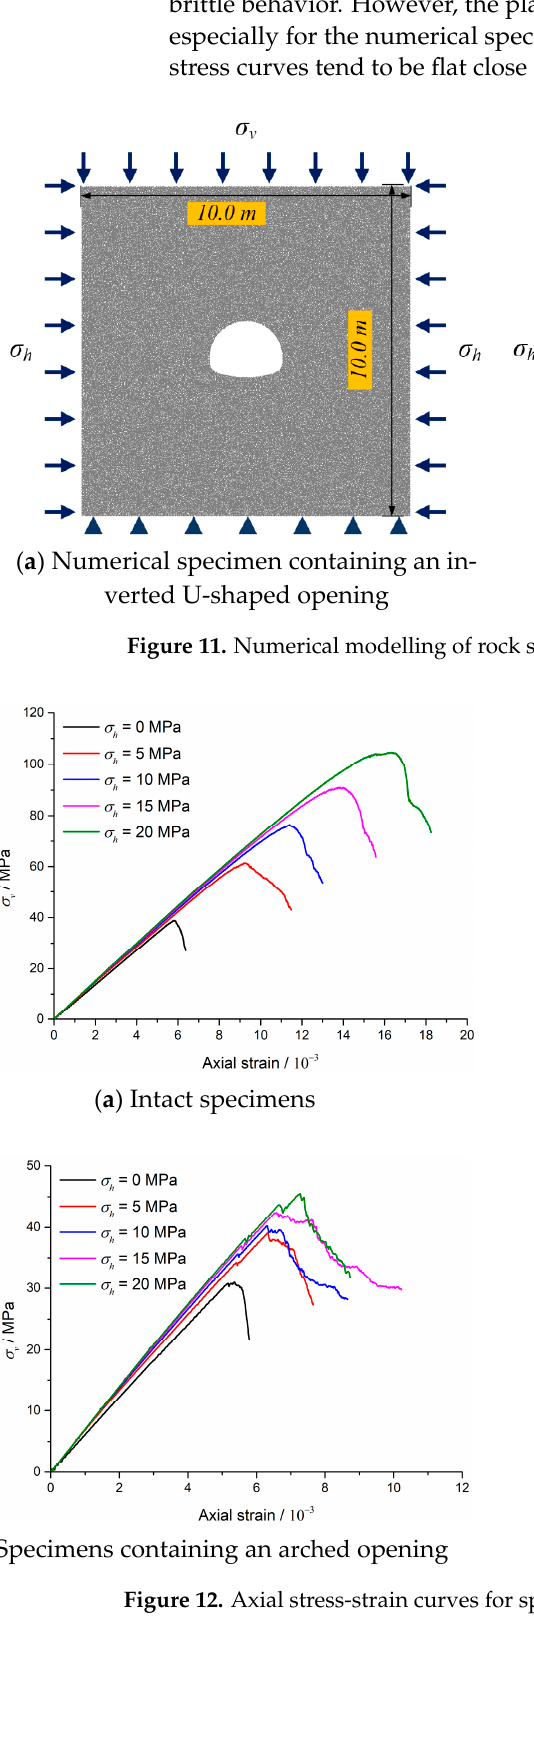
Figure 13. Peak axial stress of numerical specimens under different confining stress conditions. 4.3. Failure Patterns Figure 14 and Figure 15 present the failure patterns of specimens in some representa- tive cases. The left part of each sub-figure plots the failure pattern of the specimen at the point of 95% peak axial stress in the pre-peak stage and the right part plots the failure